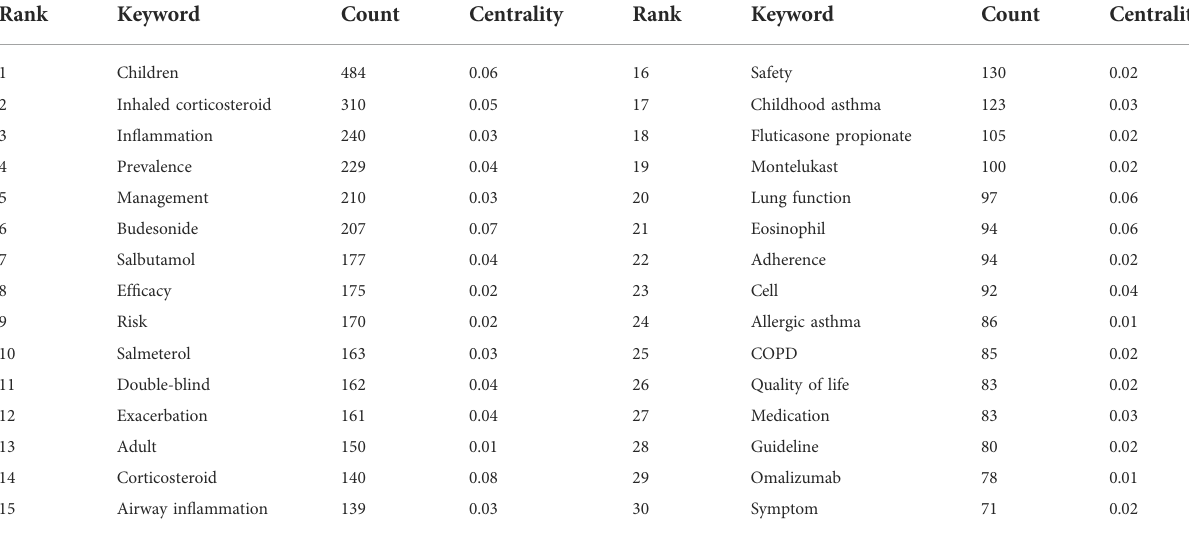
TABLE 1 Top 30 keywords with the highest count in asthma drug-related